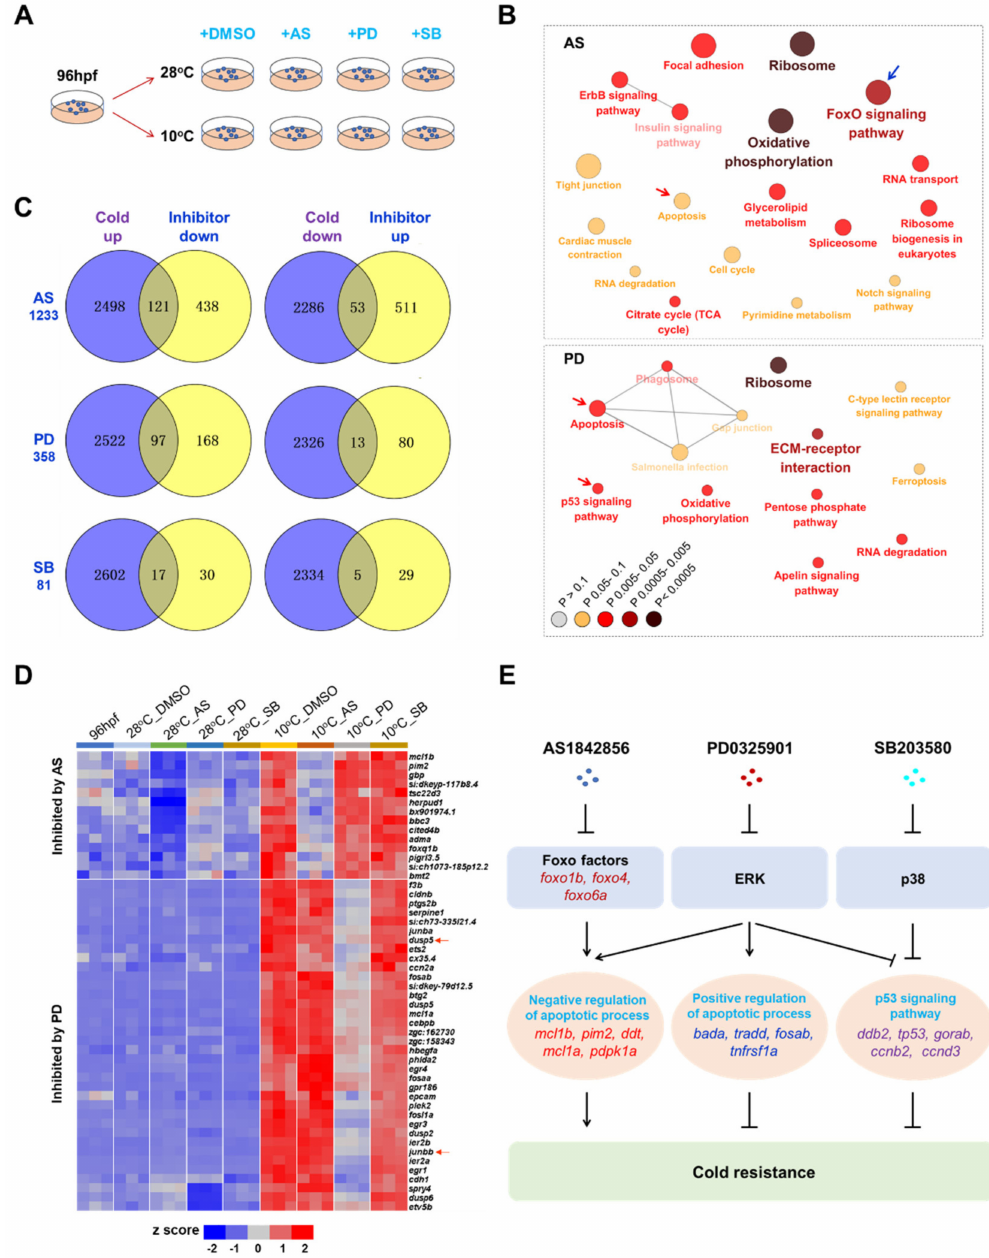
Figure 8. Characterization of the molecular mechanisms underlying functions of Foxo1, ERK and p38 MAPKs in regulating cold resistance. ( A ) Samples used for RNA-seq. Zebrafish larvae at 96 hpf were exposed to 10 ◦ C or maintained at 28 ◦ C for 12 h in the presence of inhibitors for Foxo1 (AS: AS1842856, 0.5 µ M), ERK (PD: PD0325901, 5 µ M) or p38 MAPKs (SB: SB203580, 50 µ M). DMSO is the vehicle control. ( B ) KEGG pathway enrichments of the DEGs between samples exposed to 10 ◦ C in the presence of inhibitors (AS, upper panel; PD, lower panel) and the vehicle control (10 ◦ C_DMSO). ( C ) Venn plots demonstrate the cold-responsive genes (CRGs) affected by the inhibitors. The genes up or down-regulated by cold stress (10 ◦ C_DMSO vs. 96 hpf) were compared to those down-or up-regulated by the corresponding inhibitors (10 ◦ C_AS/PD/SB vs. 10 ◦ C_DMSO). ( D ) Heat map indicates the representative CRGs inhibited by AS1842856 and PD0325901. ( E ) Working model illustrating molecular mechanisms of Foxo1, ERK and p38 MAPKs in regulating cold resistance of